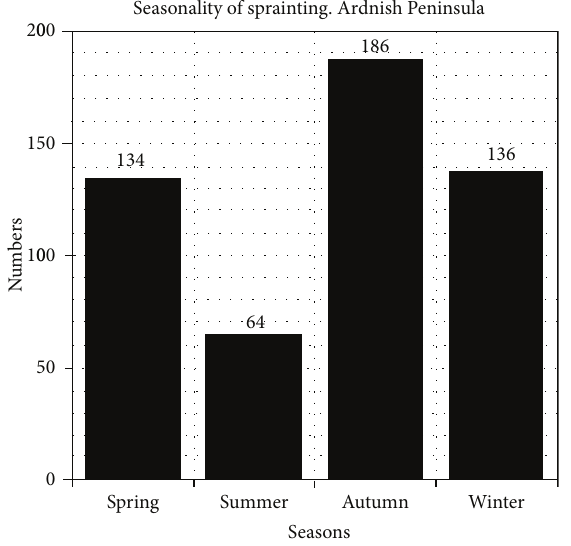
Figure 3: Seasonality of sprainting at Loch na